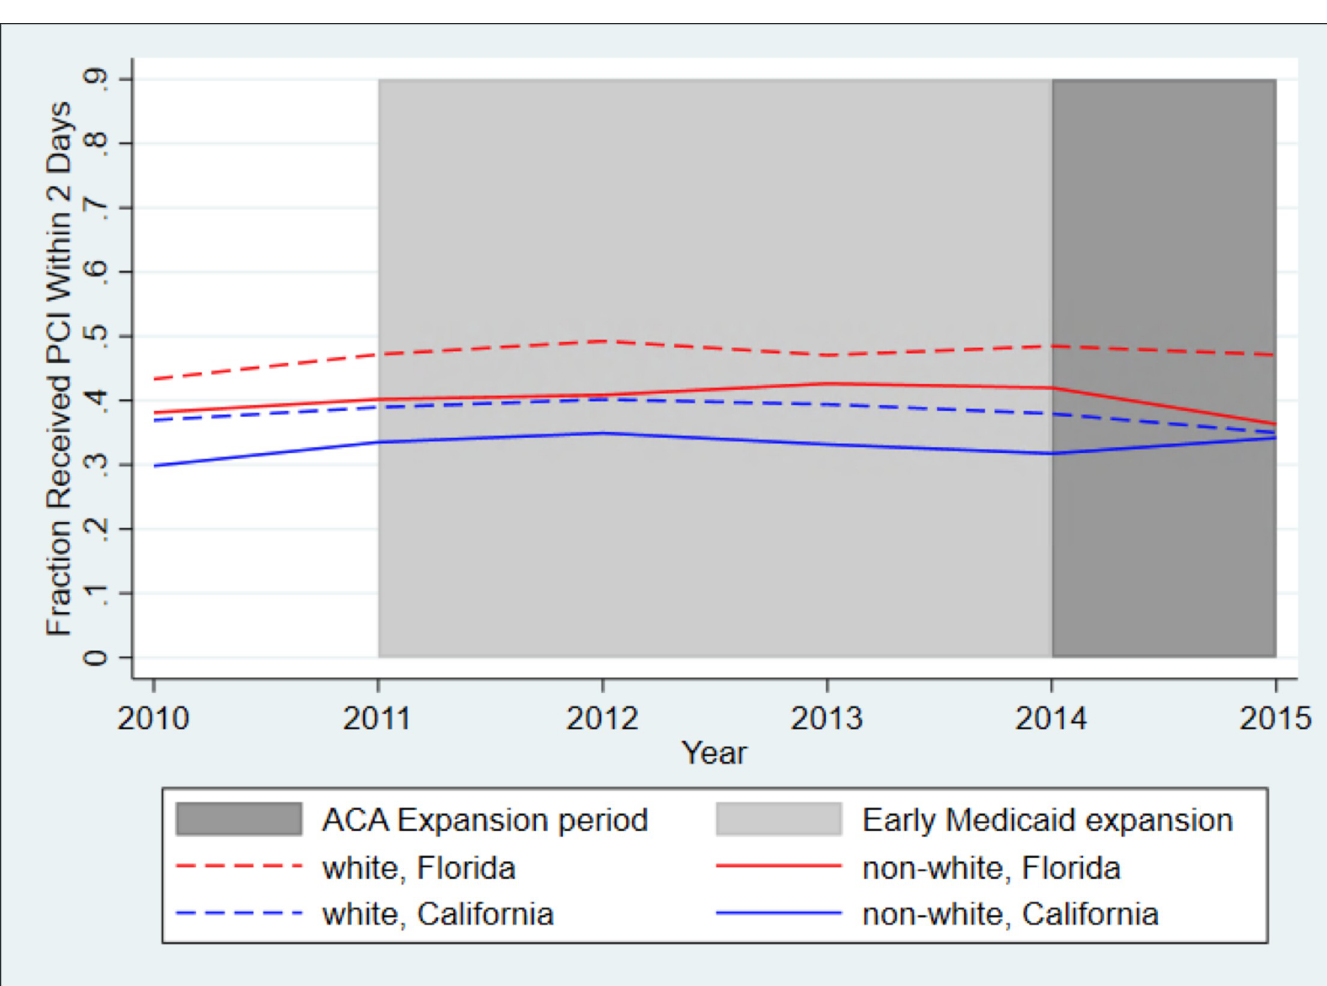
Fig 3. Unadjusted trends in likelihood of early PCI in California and Florida, white patients and minority patients. Legend : The blue dashed line shows trends for white patients in California, the blue solid line shows trends for minority patients in California, the red dashed line shows trends for white patients in Florida, and the red solid line shows trends for minority patients in Florida. While all California counties expanded Medicaid by January 2014, as indicated by the dark grey area of the graph, some California counties began expanding Medicaid at earlier dates, beginning as early as 2011, as indicated by the light grey area of the